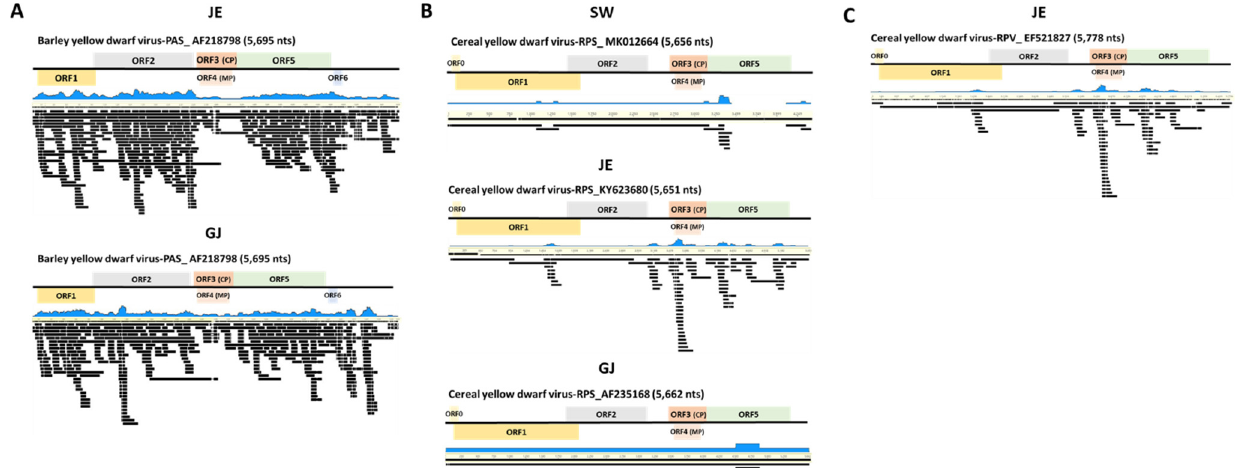
Figure 4. Genome assembly of identified BYDV-PAS isolates, CYDV-RPS, and CYDV-RPV isolates. Genome organization of assembled BYDV-PAS isolates genome from JE and GJ ( A ), CYDV-RPS isolates genome from SW, JE, and GJ ( B ), CYDV-RPV isolate genome from JE ( C ). Viral genomes were obtained from assembled virus-associated contigs and their mapping on the reference virus genome.